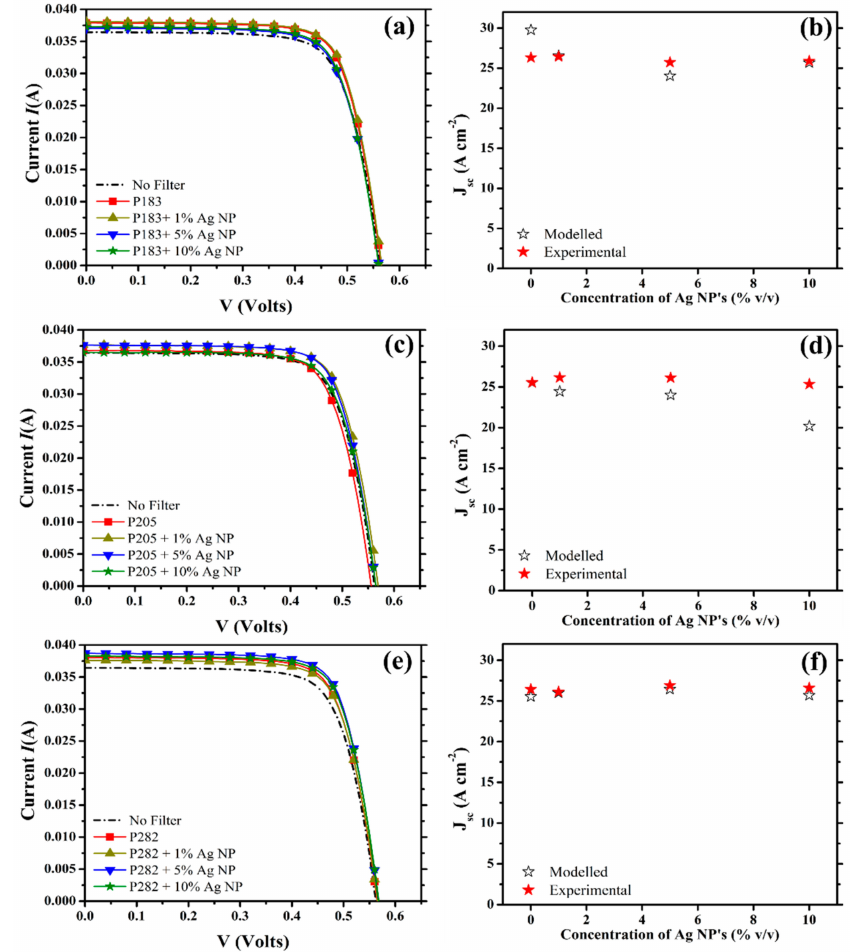
Figure 4. Current–voltage (I–V) response curve of the C-PV mc-Si cell when filtered by the ( a ) P183, ( c ) P205, and ( e ) P282 PLDS nanofluid filters employing di ff erent concentrations of the nanoparticles. The performance of the C-PV solar cell in the absence of any liquid filter (‘No Filter’) is also included. To be noted that only a small area (7 mm × 25 mm) of the mc-Si cell was exposed to the incoming irradiance during the experiment. The comparison between the impact of each nanofluid optical filter on the short circuit current density (J SC in A cm − 2 ) of the ‘filtered’ solar cell in response to an increased loading concentration of the nanoparticle (( b )—P183, ( d )—205, ( f )—P282) under the modelling (modelled—black unfilled stars) scenario and the experimental (experimental—red filled star) conditions is presented. The performances reported in each case reflect solar cell performances at a cell temperature 30 ± 0.2 ◦